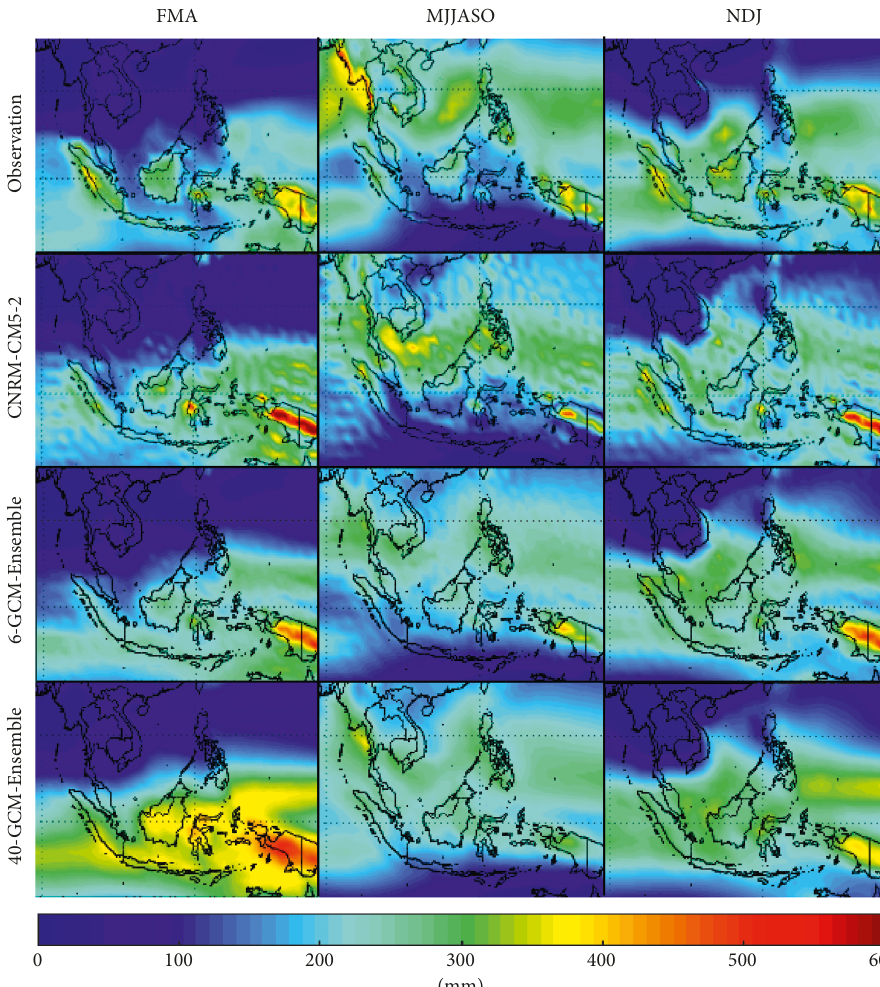
Figure 12: Comparisons of average seasonal precipitation (mm season − 1 ) for years 1960–1999 of observations, CNRM-CM5-2, 6-GCM- Ensemble, and 40-GCM-Ensemble, from top to bottom rows, respectively. Columns from left to right show hot (FMA), rainy (MJJASO), and cold (NDJ) seasons, respectively. Table 6: Correlation coefficients (CCs) between observations and model simulations, standard deviations (STDs) normalized by the